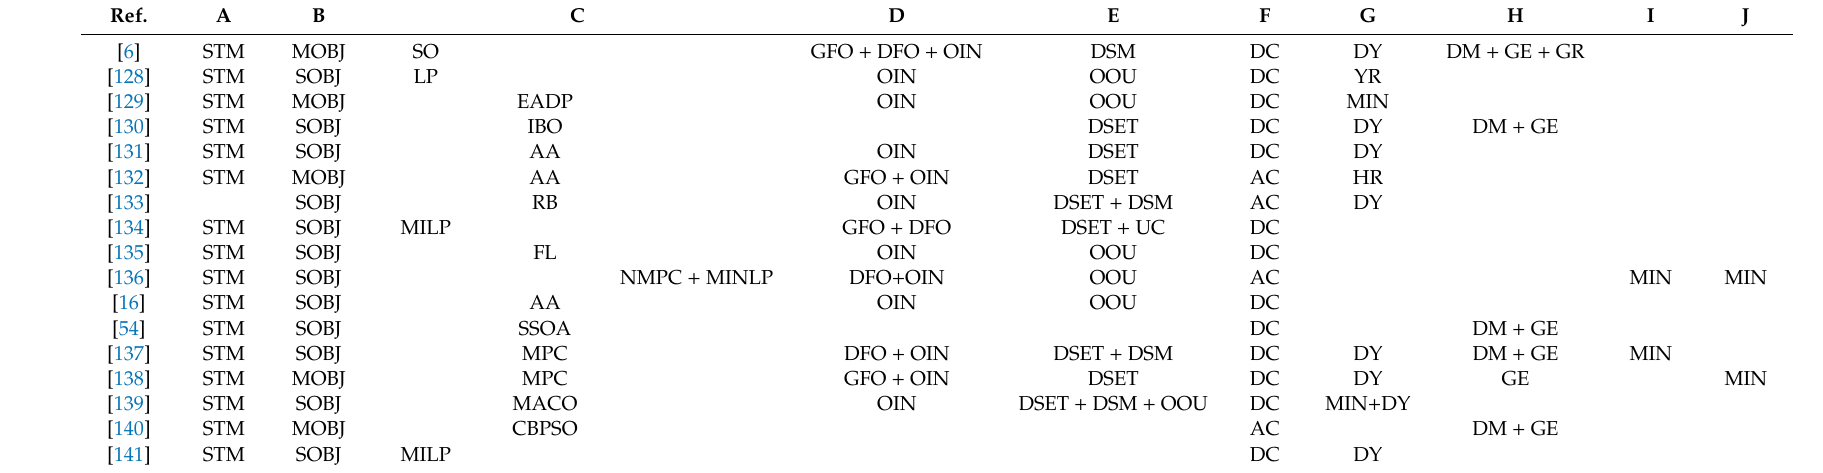
Table A8. Papers published in 2016.